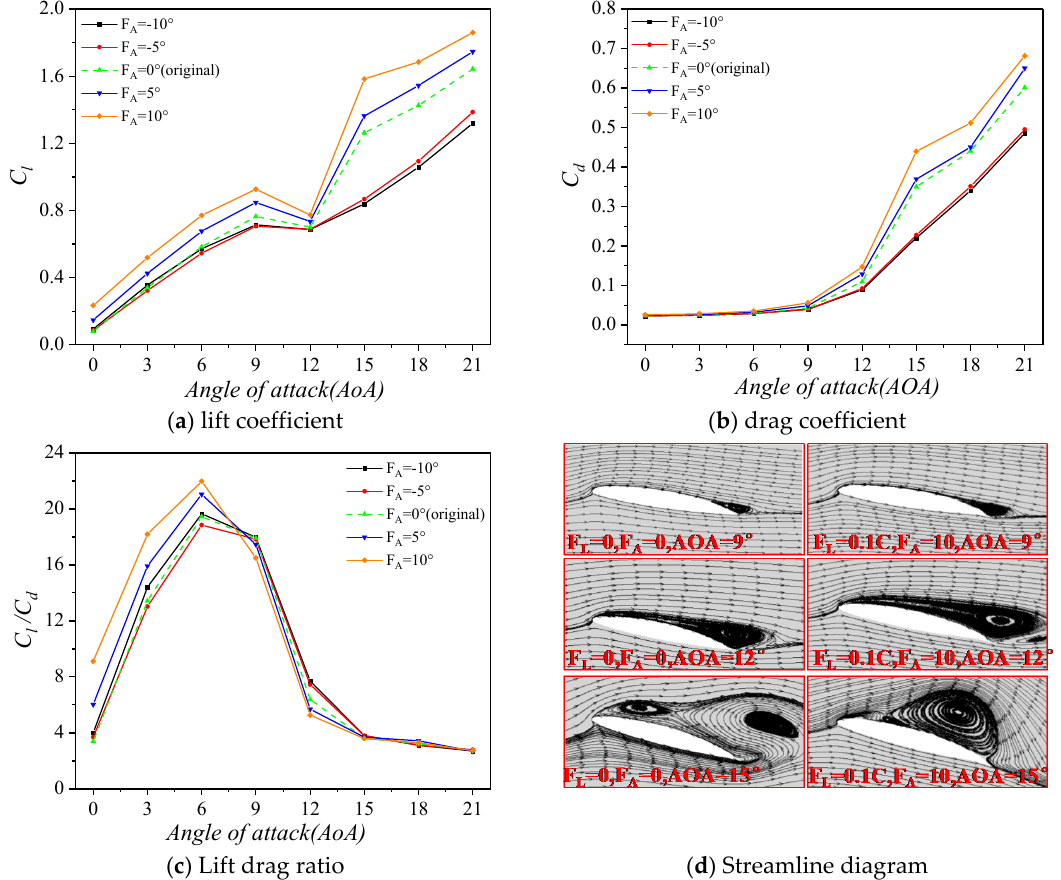
Figure 6. Influence of F A on hydrodynamic performance of hydrofoil (Re = 3.5 × 10 5 ; F L = 0.1C).